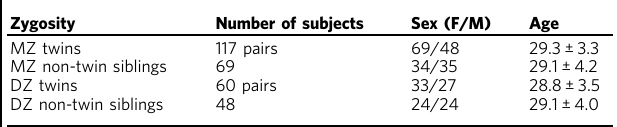
Table 1 Demographic data for twin groups and their non- twin